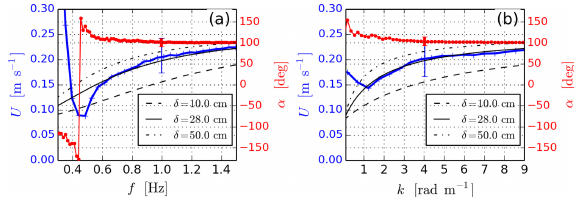
Figure A1. Effective current magnitude (blue) and direction (red) as a function of frequency (a) and wavenumber (b) , after smoothing over five adjacent points. Superimposed are the analytical profiles corresponding to a typical wind drift current when u b = 0 . 1ms − 1 with various values of δ (see text for